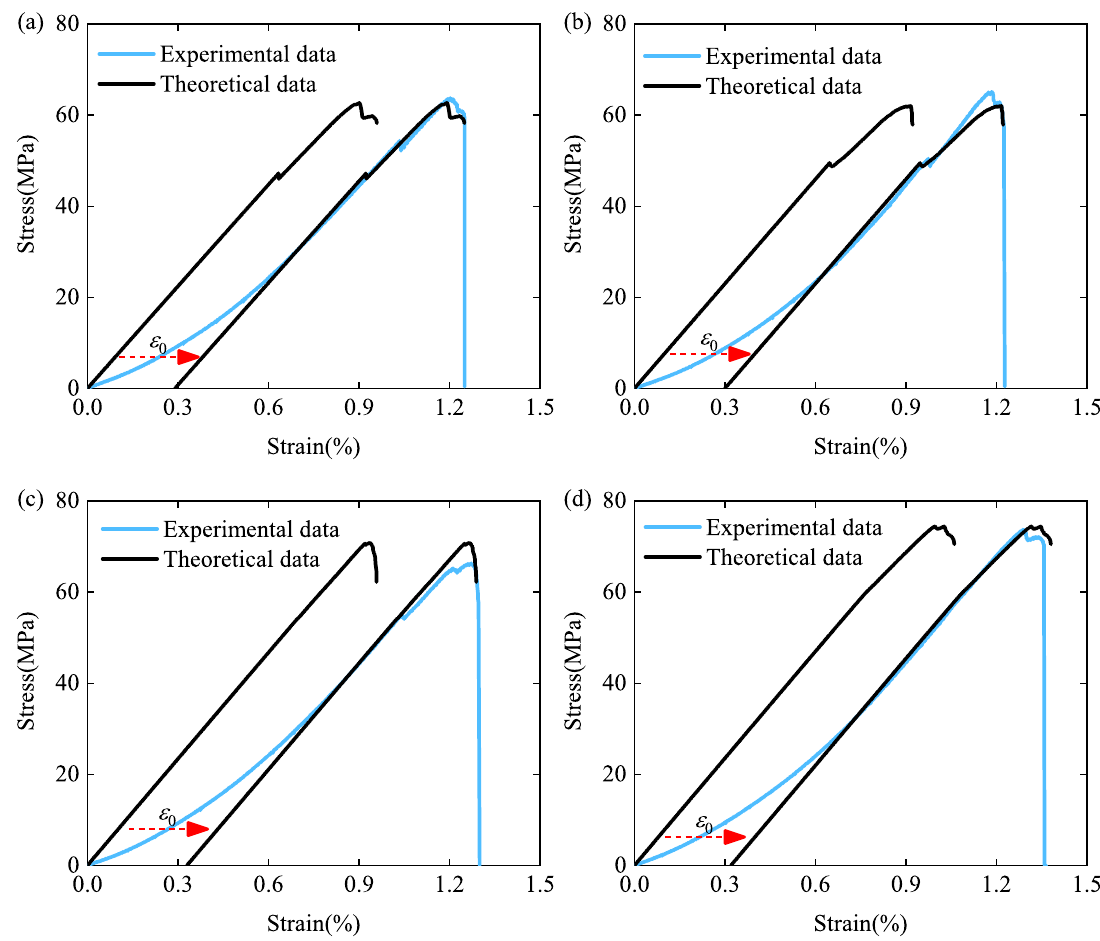
Figure 12. Comparisons between test data and theoretical calculation: ( a ) Specimen No. 0-1, ( b ) Specimen No. 30-1, ( c ) Specimen No. 45-1, and ( d ) Specimen No.